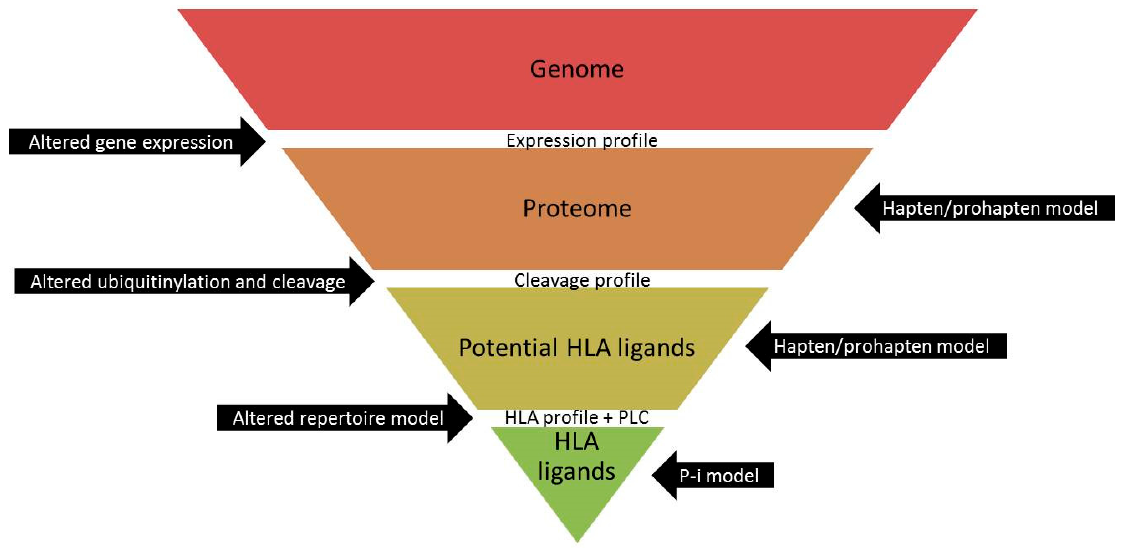
Figure 1. Filters to be passed before a human leucocyte antigen (HLA) ligand is presented by a HLA molecule. Opportunities to influence peptide presentation are indicated in the black arrows.